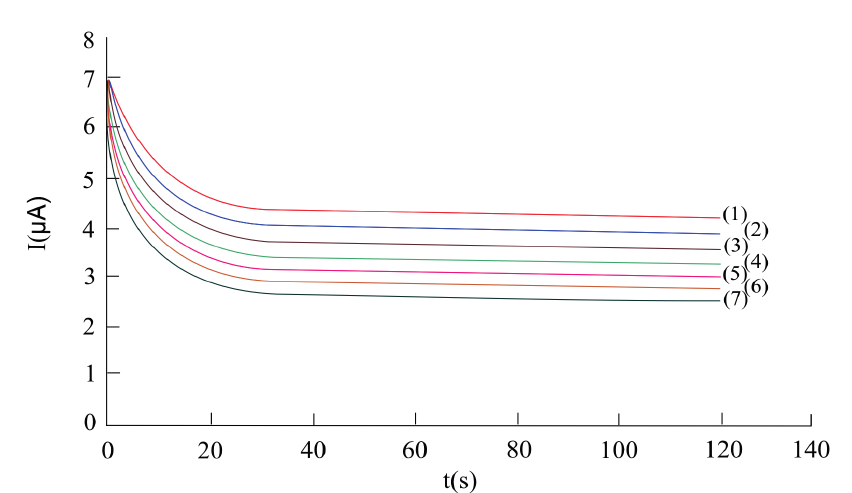
Figure 4 : Chronobiamperograms obtained for different Trolox concentrations: (1) 0 μM, (2) 5 μM, (3) 10 μM, (4)-15 μM, (5) 20 μM, (6) 25 μM, (7) 30 μM; conditions:110 μM DPPH/100 μM DPPH·, potential difference, ΔE = 200 mV, as presented in